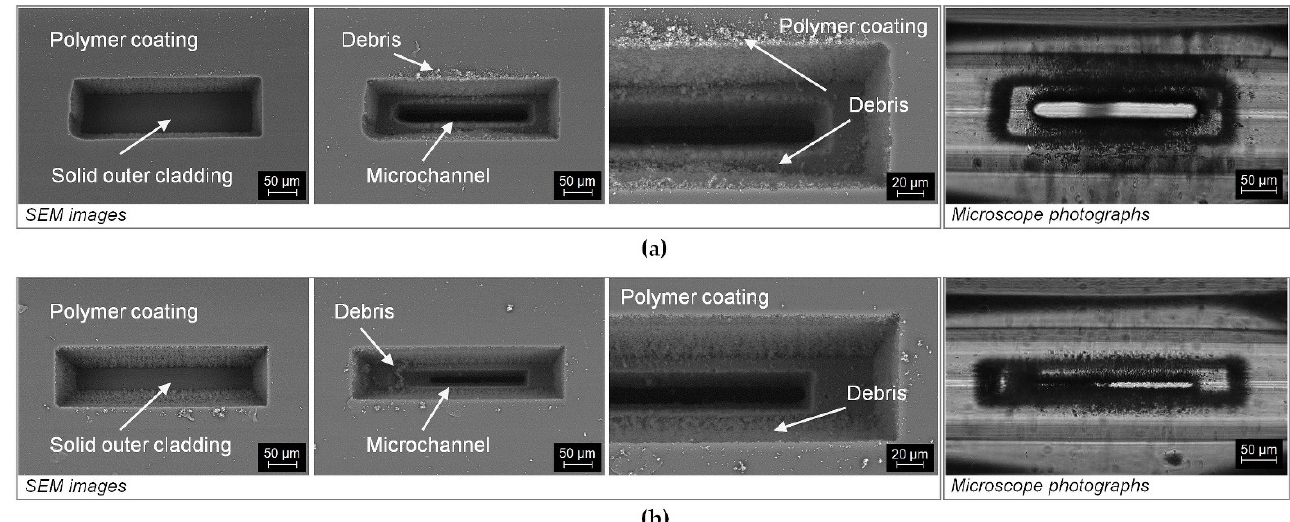
Figure 6. SEM images and microscope photographs of the polymer coating removal process and the laser microcutting of the microchannel realized in one process: ( a ) with the F-theta configuration and ( b ) with the AL configuration.